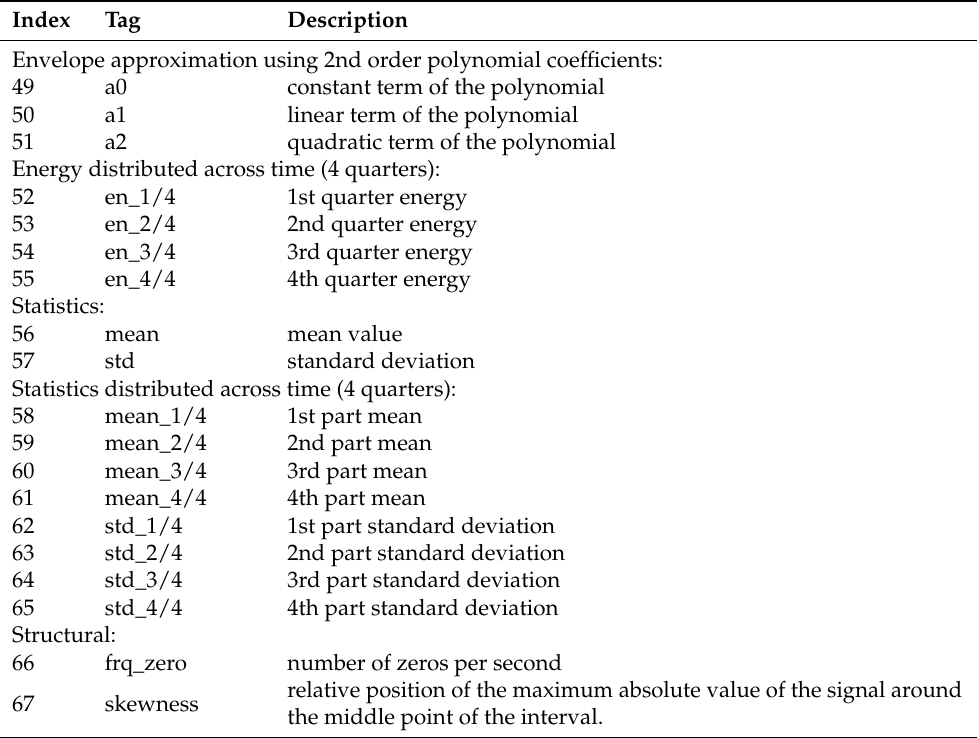
Table 4. Features extracted only from the systolic and diastolic silent intervals (tagged as m1 and m2,